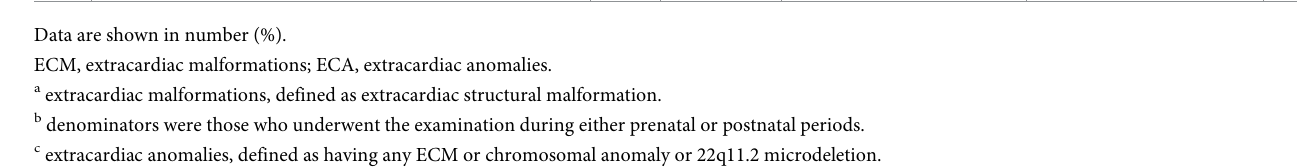
Table 3. Prevalence of extracardiac anomalies by type of congenital heart disease (total study population). No